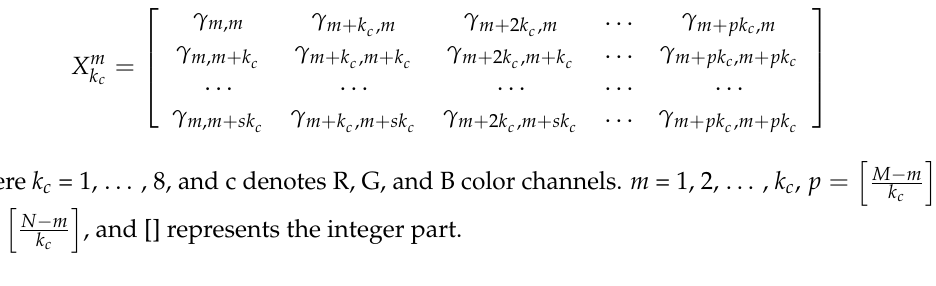
     where k c = 1, …, 8, and c denotes R, G, and B color channels. m = 1, 2, …, k c , (cid:1868) (cid:3404) (cid:4674) (cid:3014)(cid:2879)(cid:3040)